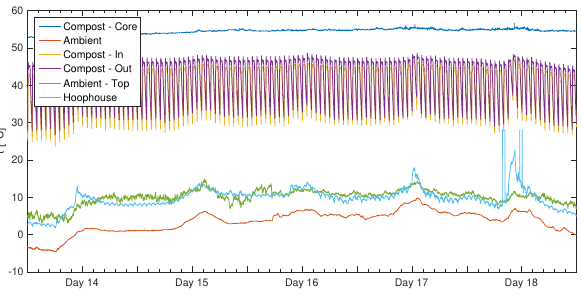
Figure 17. Temperature profiles of a 5-day period of active heat recovery (days 14–18).